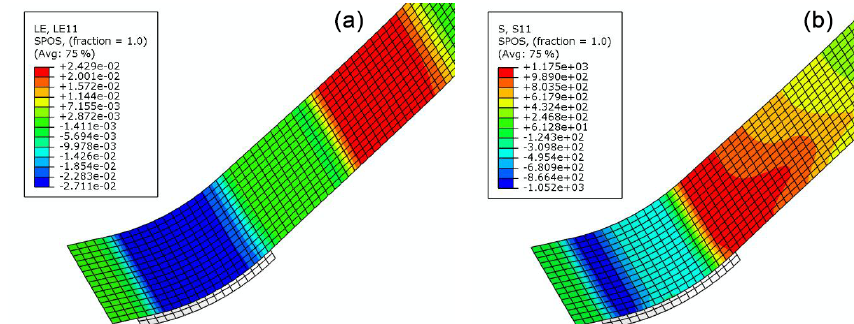
Figure 15. First principal strain (a) and stress (b) during the second segment of deformation.